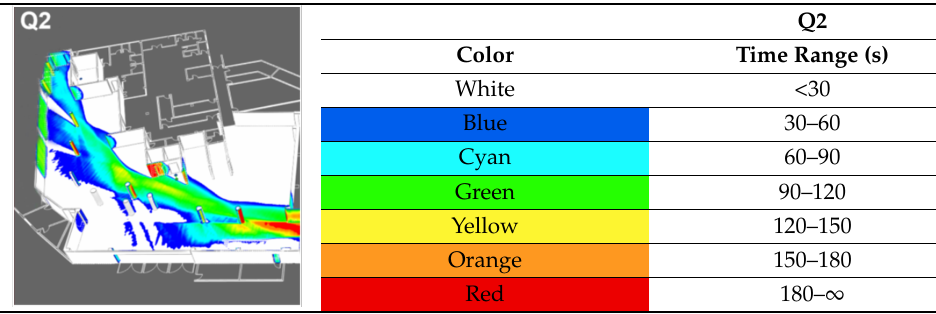
Table 4. Vision time map analysis in Q2.